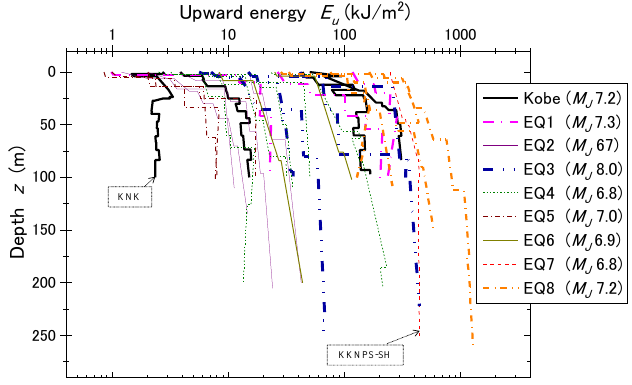
Figure 12. Variations of upward energy E u along depth calculated for nine earthquakes at 30 vertical array sites. Damping D MA 12% < 8-12% 4- 8% 0- 4% D MA : Averaged damping ratio modified for 100 m layer